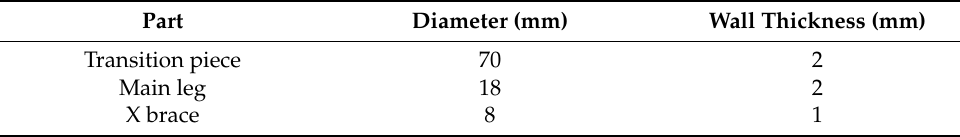
Table 2. The dimensions of model jacket structure main